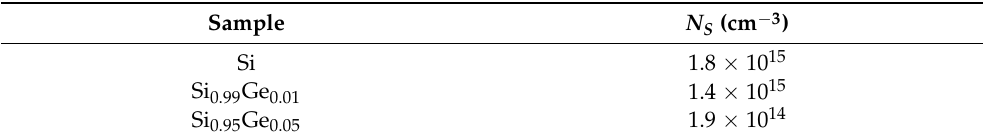
Table 1. The boron dopant concentration in diodes composed of Si and SiGe alloy evaluated using C-V